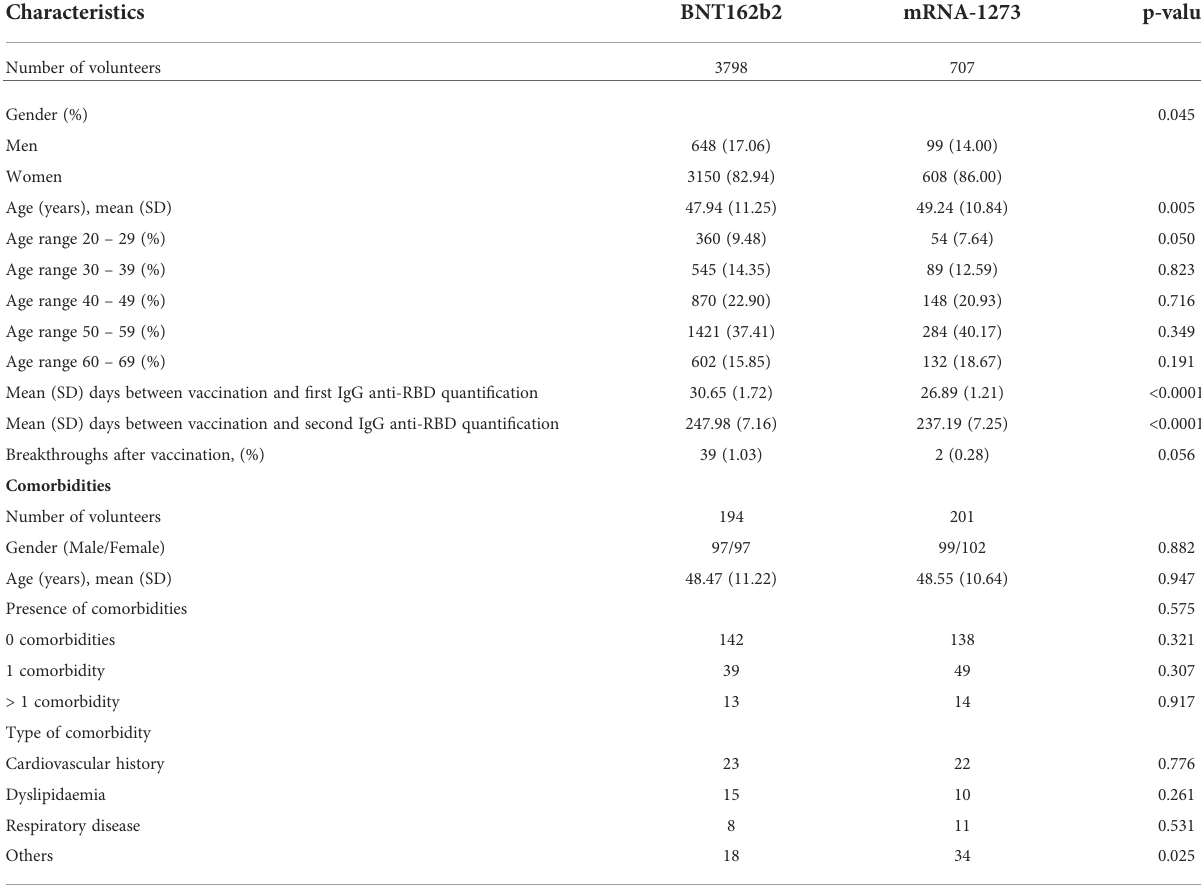
TABLE 2 Characteristics of volunteers who exhibited a wane between the fi rst and second